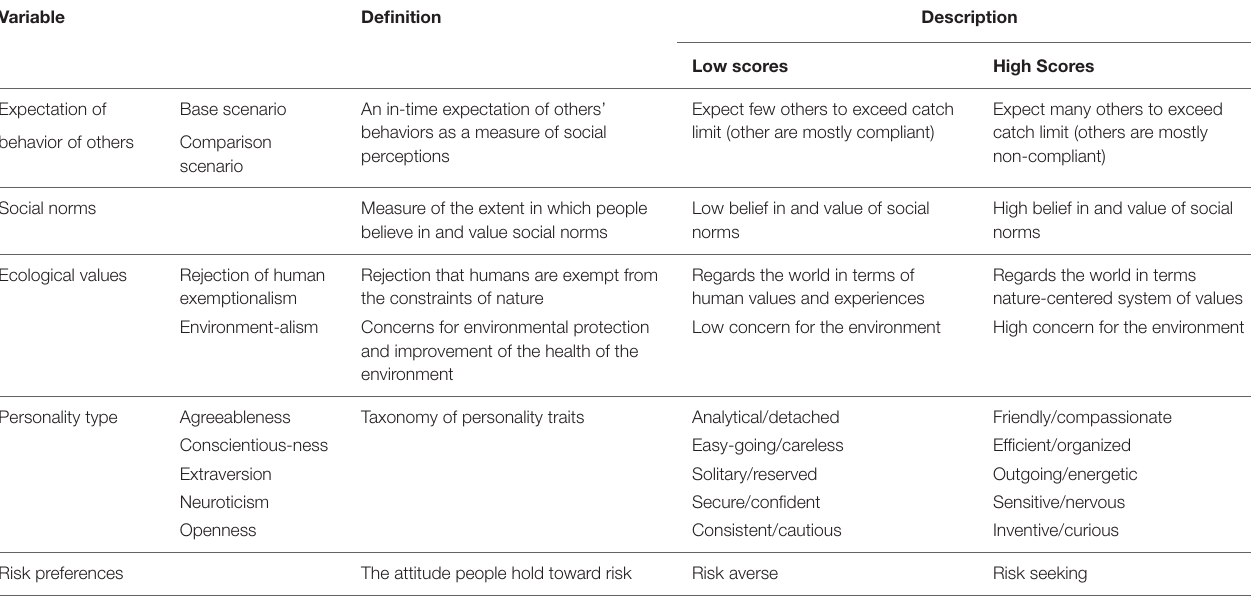
TABLE 3 | Summary of psycho-social